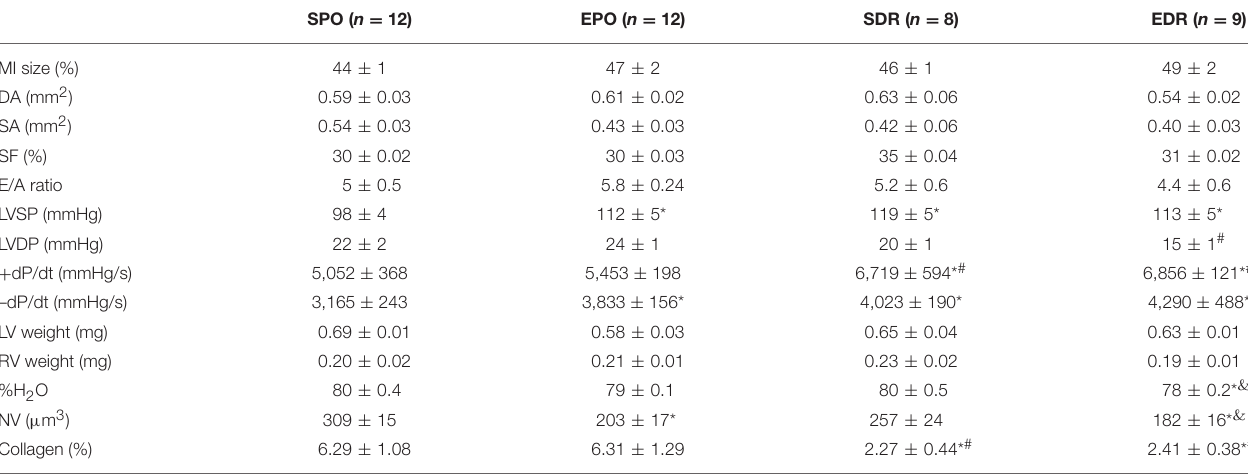
TABLE 1 | Cardiac parameters (mean ± SEM) of exercised and sedentary rats subjected to MI with or without